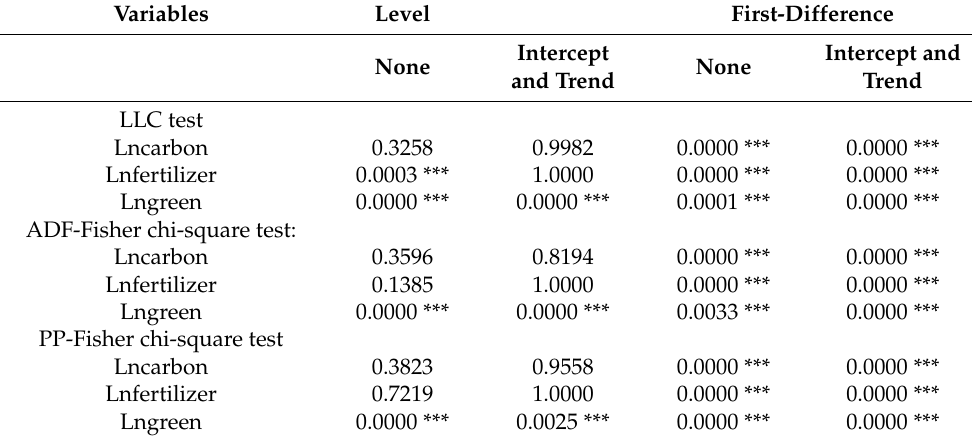
Table 6. Panel unit root tests results.